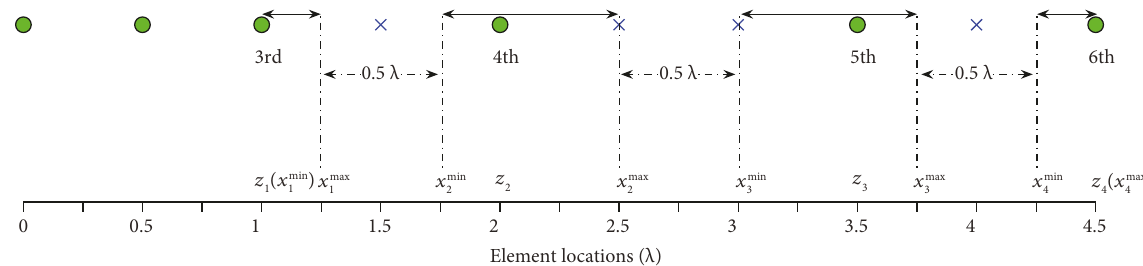
Figure 1: A thinned array to illustrate the way how to select the element locations that need to be